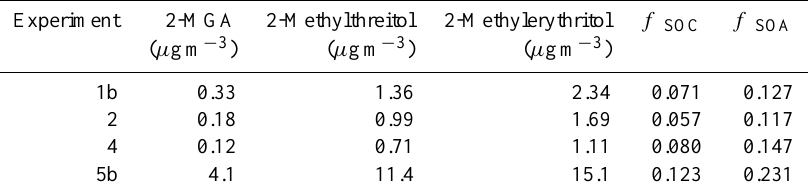
Table 5. Methyl tetrols and 2-MGA formed from irradiations in the absence of NO x . Mass fractions of these tracer compounds (defined in text) to the organic mass ( f SOA ) and organic carbon ( f SOC ) are also